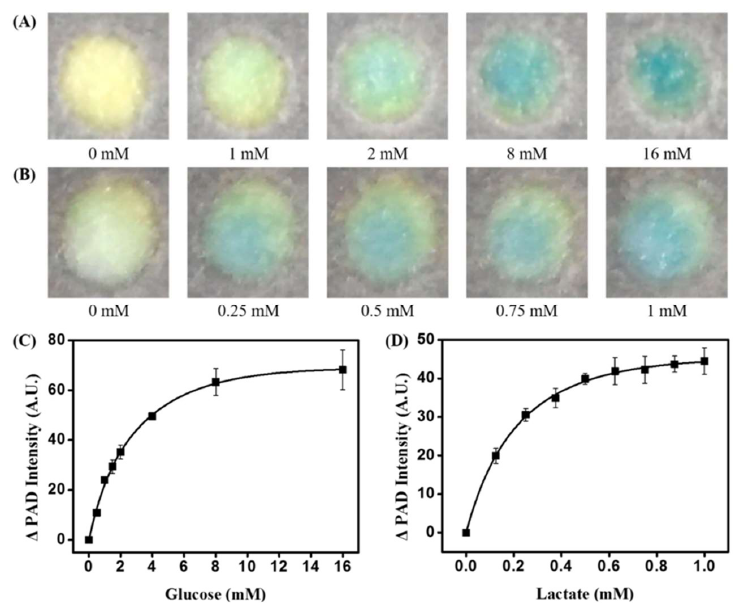
Figure 6. The process of wax-printing used to construct the sensor. ( c ) The anterior and posterior sides of the sensor. Reproduced with permission from [91]. An overview of glucose and lactate assays. ( a ) Glucose concentrations between 0-16 mM. ( b ) Lactate concentrations between 0–1 mM. ( c ) Calibration curve of glucose assay plotted using data collected at a reaction time of 60 s. ( d ) Calibration curve of lactate assay.